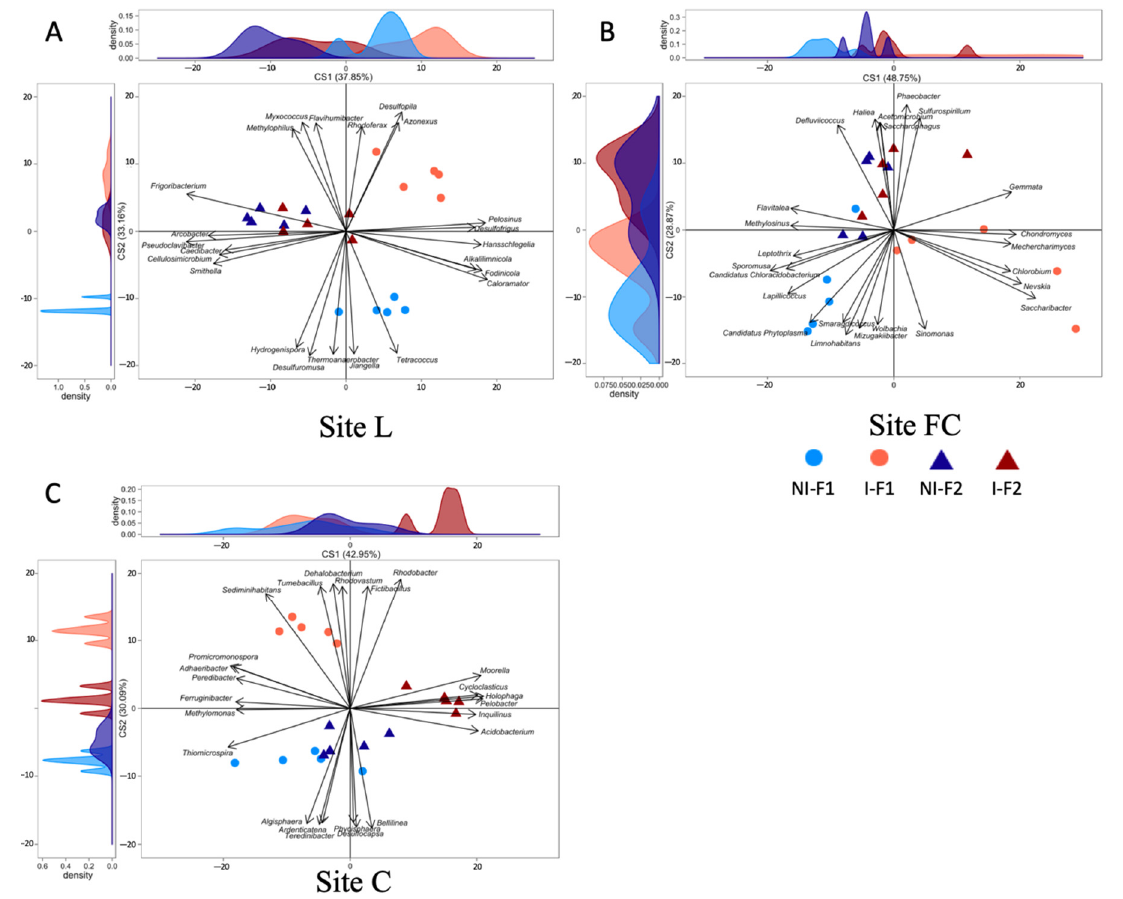
Figure 4. Effect of inoculation level of A. lipoferum CRT1 on the composition of the total bacterial community ( rrs ) as indicated by between-class analyses (BCA) studied at three field sites L ( A ), FC ( B ), and C ( C ). F1 (circles) corresponds to the peat matrix used to coat seeds with low inoculant concentration, using data originating from [21], and in F2 (triangles), A. lipoferum CRT1 was used at higher inoculant concentration. NI (blue) and I (reddish) correspond, respectively, to non-inoculated and inoculated conditions. Curves on top and left represent, respectively, the sample distribution on abscissa and ordinate axes. Vectors on plot represent the bacterial genera contributing the most to sample distribution.